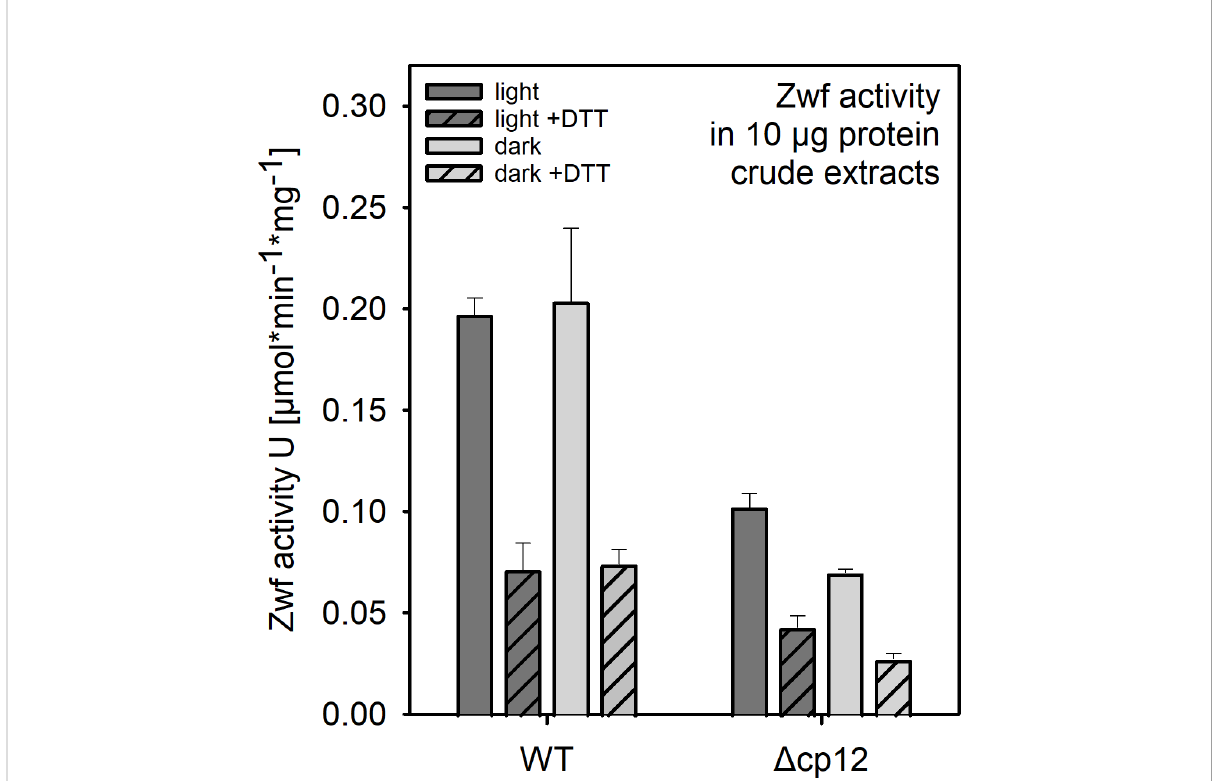
FIGURE 5 Glucose 6-phosphate dehydrogenase (Zwf) activities in the Synechocystis wild type (WT) and mutant D cp12. Speci fi c enzyme activities were measured in crude protein extracts from cells exposed to light or dark conditions in the presence of saturating glucose 6-phosphate amounts under oxidizing or reducing (+ 5 mM DTT). Data from one representative experiment are